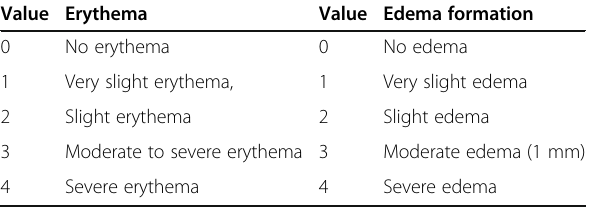
Table 3 Draize score evaluation criteria for skin irritation study Value